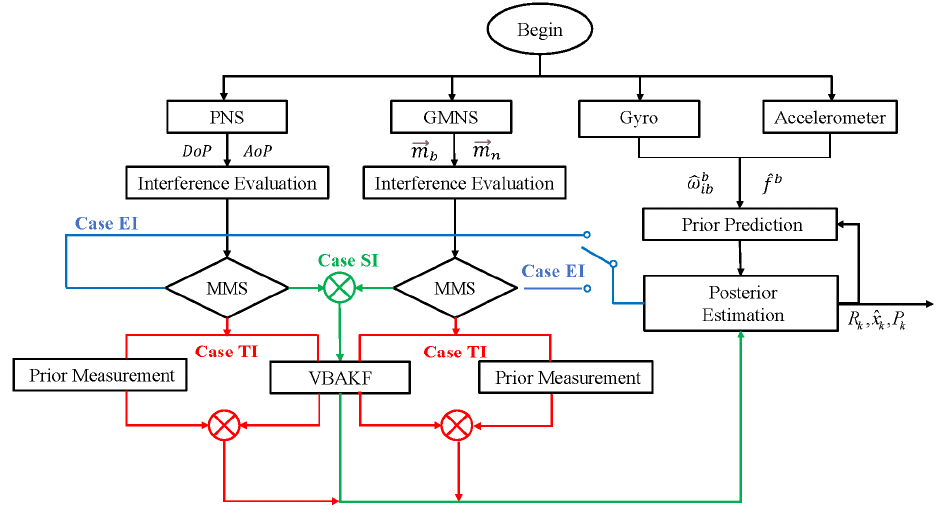
Figure 2. The flowchart of the MMS-VBAKF method.